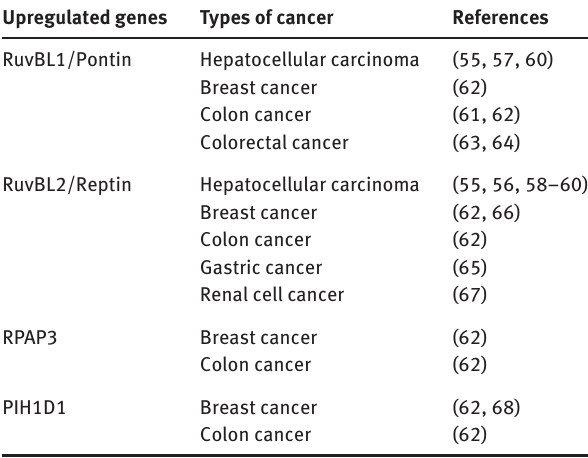
Table 2 The upregulation of R2TP in various